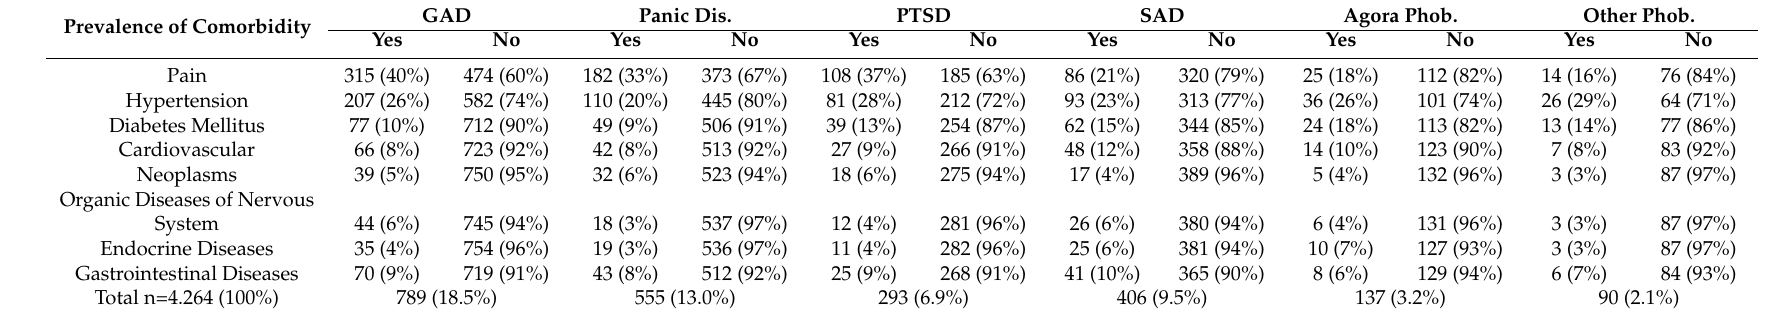
Table 3. Prevalence of physical comorbidities among those with depressive disorder co-occurring with anxiety disorder.